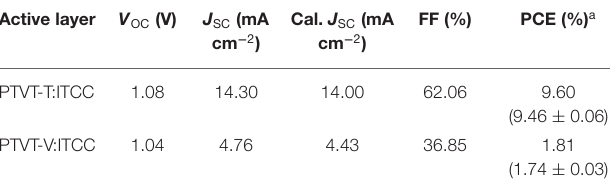
TABLE 1 | Photovoltaic parameters of the OPV cells based on PTVT-V:ITCC and PTVT-T:ITCC under the illumination of AM 1.5G, 100 mW cm − 2